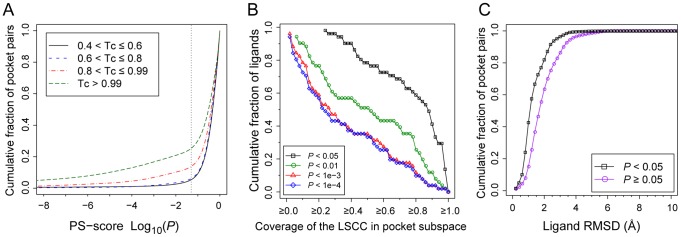
Statistics of protein pockets recognizing similar or identical ligands.(A) Cumulative fraction of pocket pairs at a pocket similarity better than then given PS-score P-value. Each pair of pockets bind to similar or identical ligands in various Tc regimes. The dotted line is located at P = 0.05. (B) Cumulative fraction of ligands versus the coverage of their largest pocket cluster defined by the LSCC. The coverage is the size of the LSCC divided by the number of all pockets within each ligand's pocket space. (C) Cumulative faction of identical ligand pairs with an atomic RMSD less than a given value. Ligand pairs are categorized into two groups according to the similarity of their corresponding pockets. A PS-score P of 0.05 was employed as the threshold for the categorization.